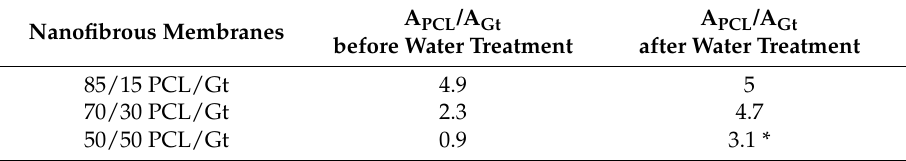
Figure 6. SEM images of PCL/Gt blend nanofibers (13 wt%, 70/30 AA/FA) with different PCL/Gt ratios ( a – d ) before and ( e – h ) after water treatment, i.e., rinsing with demineralized water at 35 °C. Mass loss is calculated by weighing the dried weight. Based on this mass loss of gelatin, a new PCL/Gt ratio was calculated for the rinsed samples. Table 2. Composition of the nanofibrous membranes before and after water treatment, analyzed using the ratio of the carbonyl stretching peak of PCL and the amide I peak of gelatin measured using FTIR. After water treatment, the composition is comparable and reflecting a gelatin concentration of about 15 wt%.